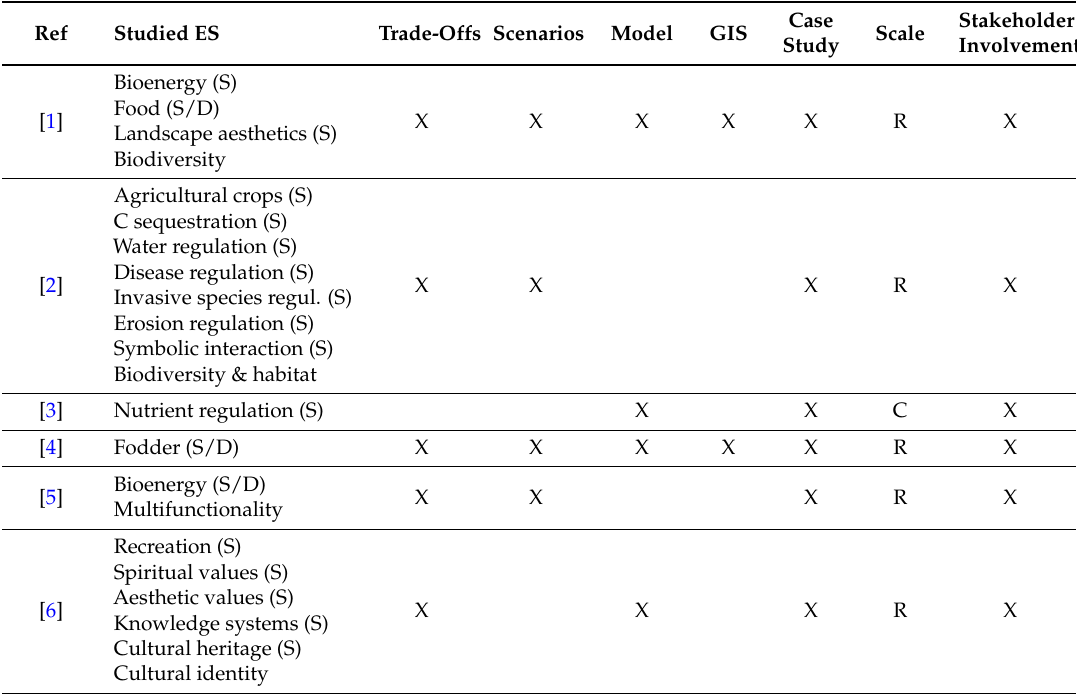
Table 1. Overview of the articles in this Special Issue. Most of the studies (4) dealt with provisioning ecosystem services (ES), fewer with regulating ES (2) or cultural ES (3). All studies included a (in most cases regional) case study and involved